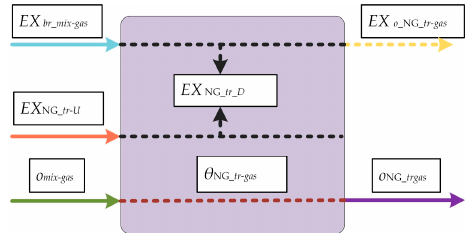
Figure A4. Process flowsheets of NG-tr .